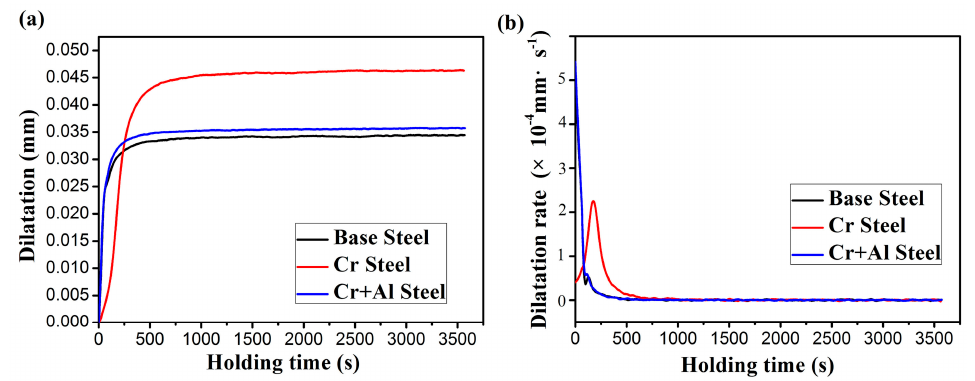
Figure 7. ( a ) Dilation curves and ( b ) transformation rates of three steels recorded by dilatometer on thermal simulator during bainitic transformation at 350 °C.